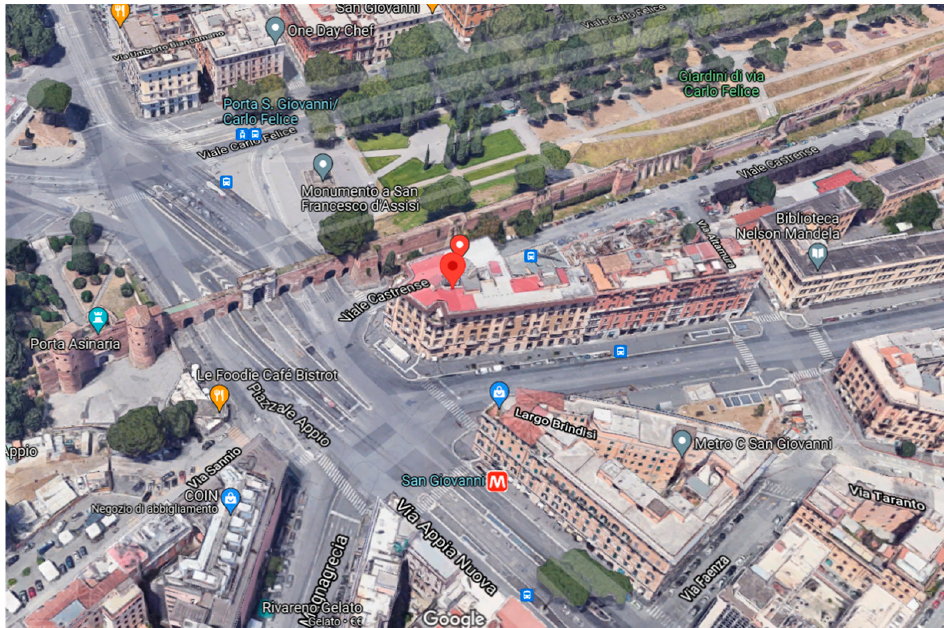
Figure 6. View of the analyzed building on the map, at the intersection of Via Emanuele Filiberto and Via Castrense (https://www.google.it/maps/place/41%C2%B053’09.2%22N+12%C2%B030’36.6%22E/@41.8835837, 12%C2%B030\T1\textquoteright36.6%22E/@41.8835837,12.5093078,320a,35y,39.39t/data=!3m1!1 12.5093078,320a,35y,39.39t/data=!3m1!1e3!4m5!3m4!1s0x0:0xfe6a6f12a7bebc20!8m2!3d41.885885!4d e3!4m5!3m4!1s0x0:0xfe6a6f12a7bebc20!8m2!3d41.885885!4d12.510169, accessed on 25 January 2022). 12.510169, accessed on 25 January 2022).